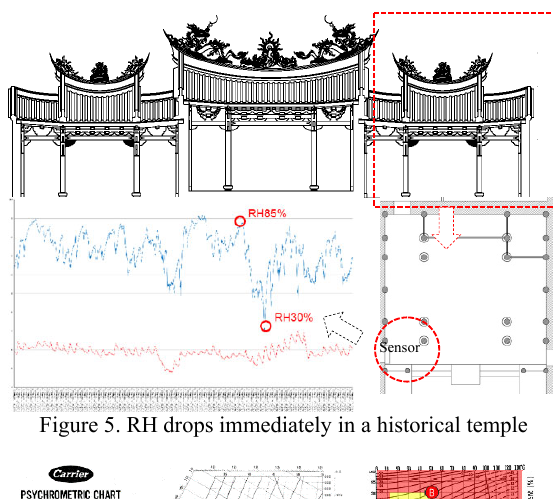
Figure 4. Painting damage between 2010 and 2016